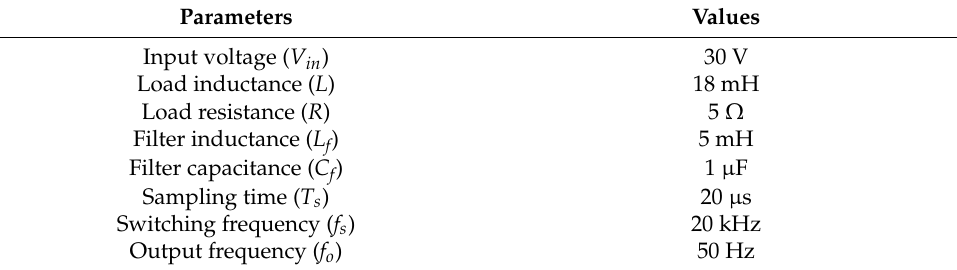
Table 1. Simulation parameters.